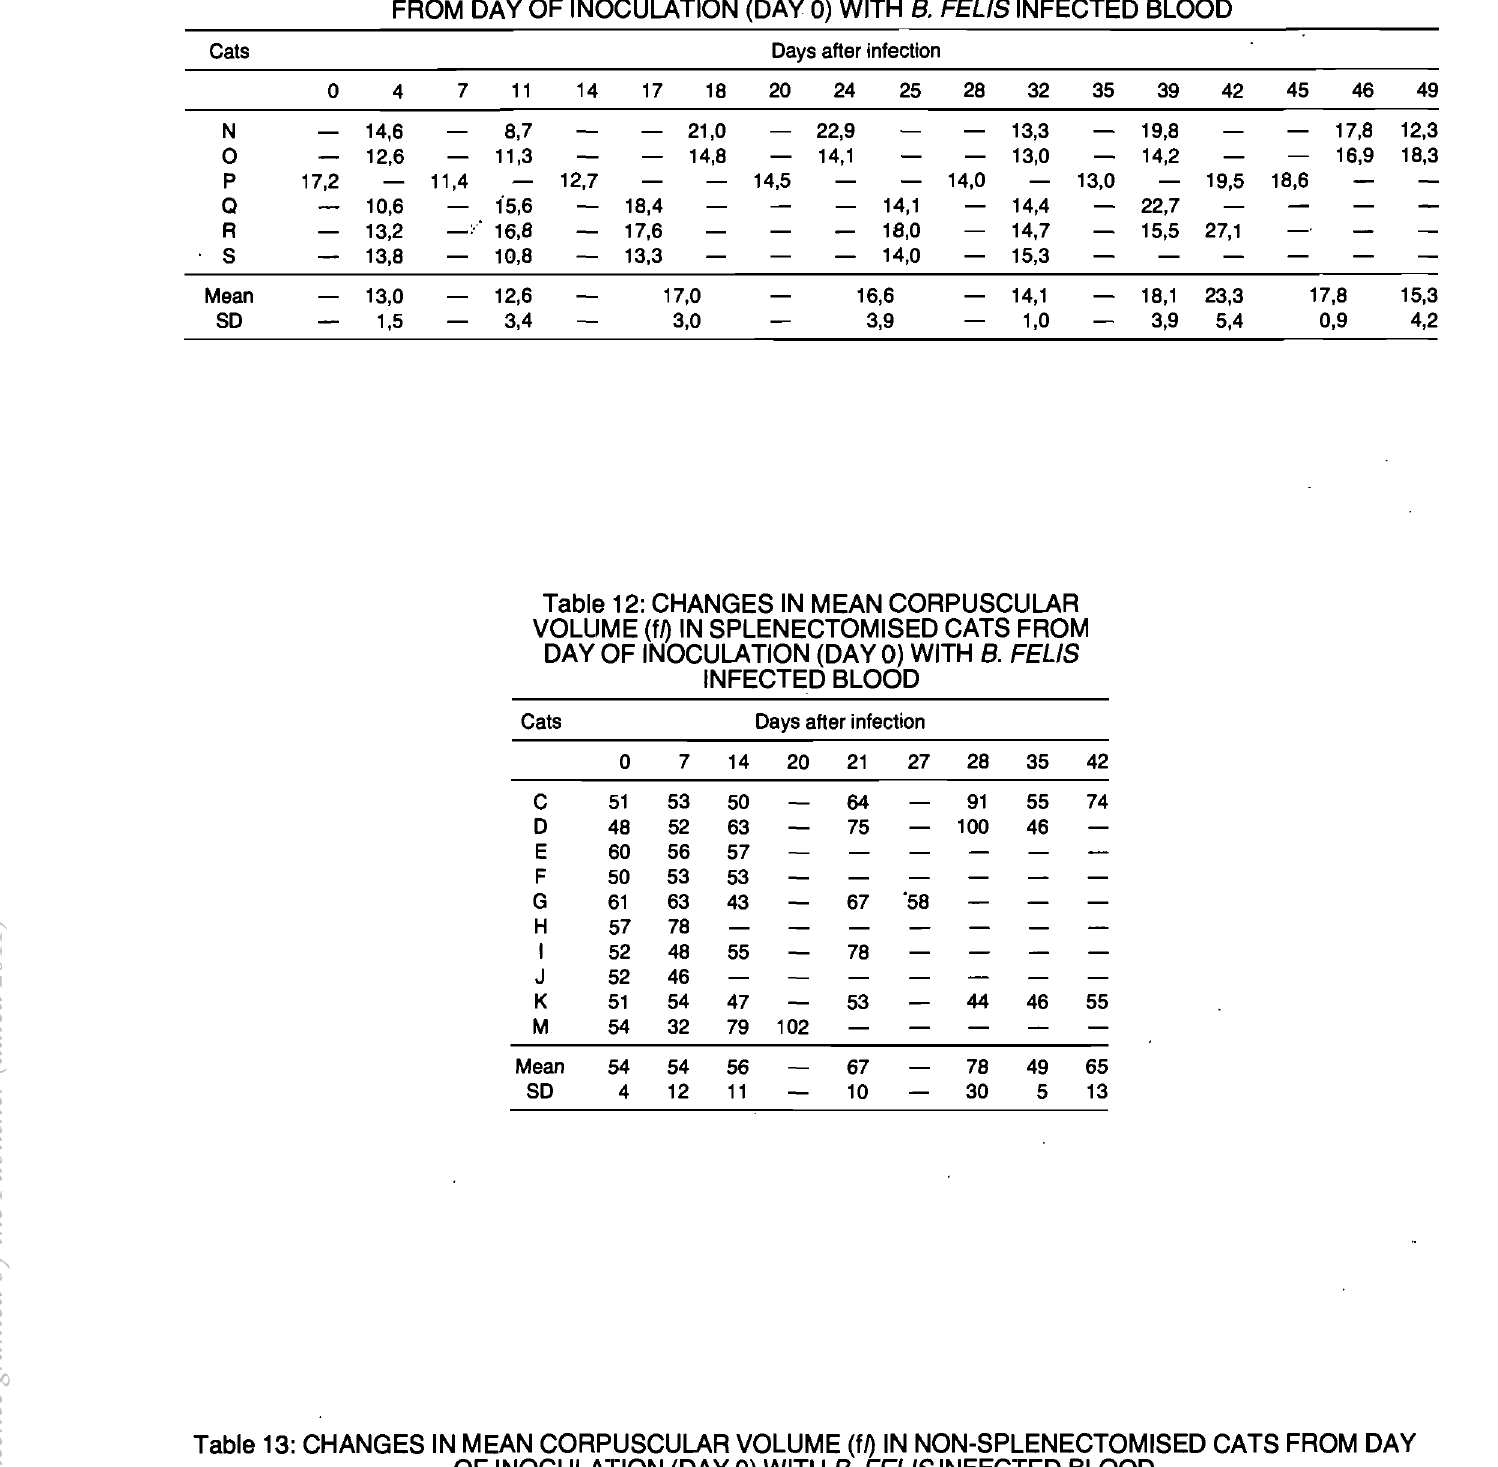
Table 13: CHANGES IN MEAN CORPUSCULAR VOLUME (f~ IN NON-SPLENECTOMISED CATS FROM DAY OF INOCULATION (DAY 0) WITH B. FELIS INFECTED BLOOD Cats . Days after